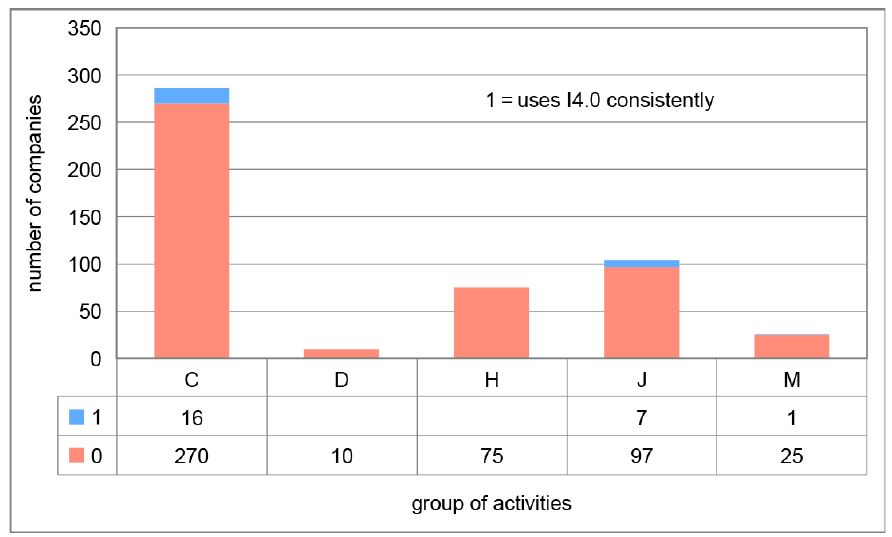
Figure 2. Distribution of the training sample.